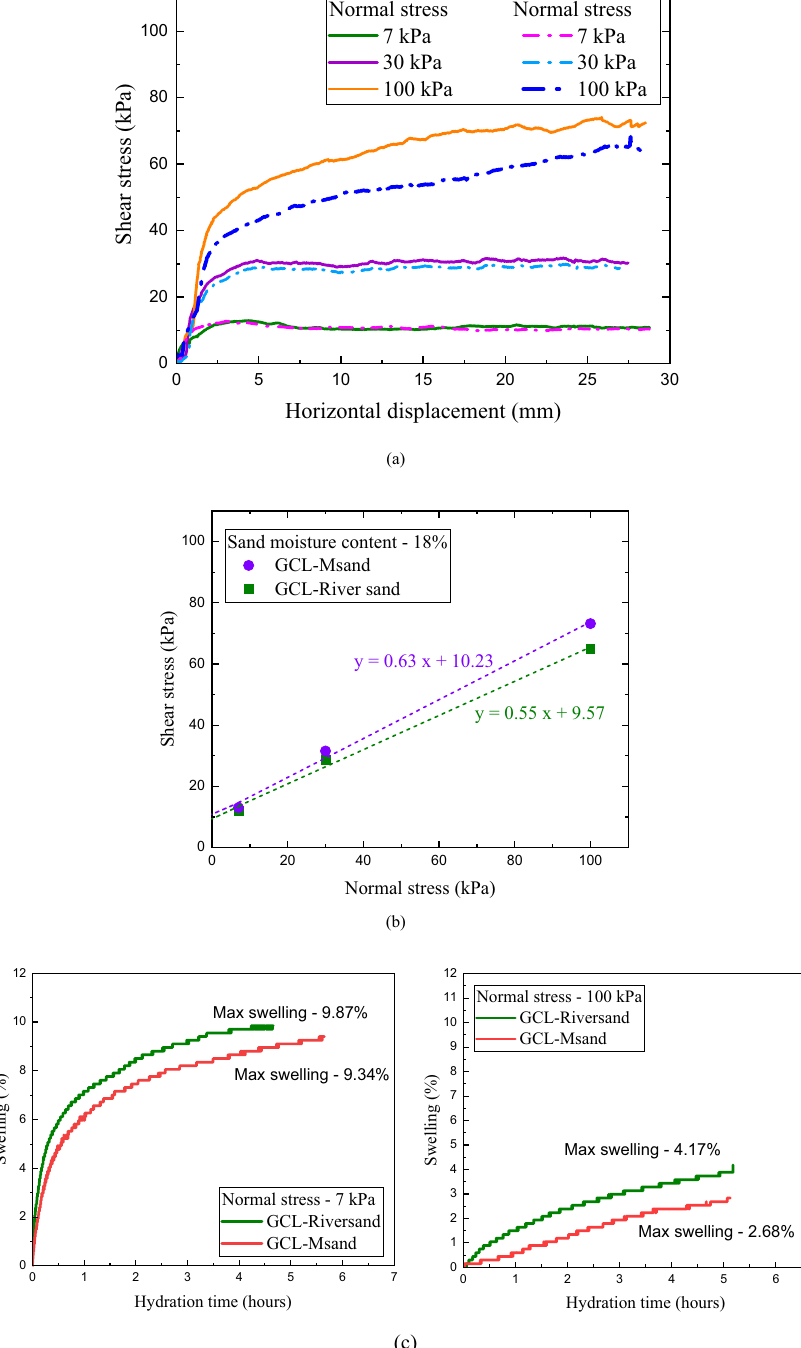
Figure 8. Shear response of GCL-sand interfaces under saturated condition ( a ) stress–displacement response, ( b ) failure envelopes, ( c ) swelling-hydration time